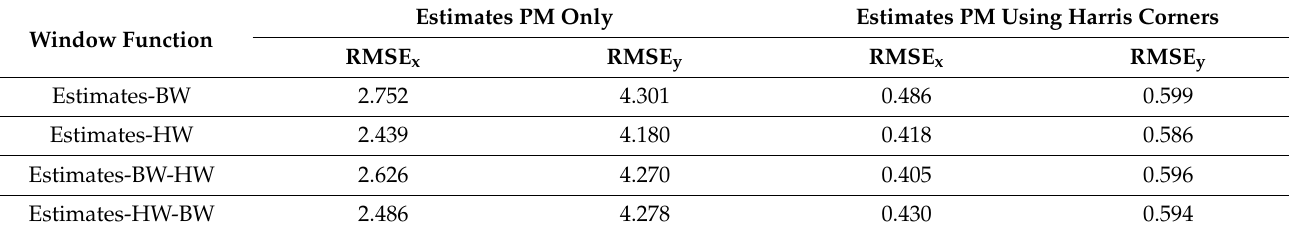
Table 4. Results for the PM only and the PM using Harris corners with different types of window functions. PM: Phase Matching. The unit of RMSE is